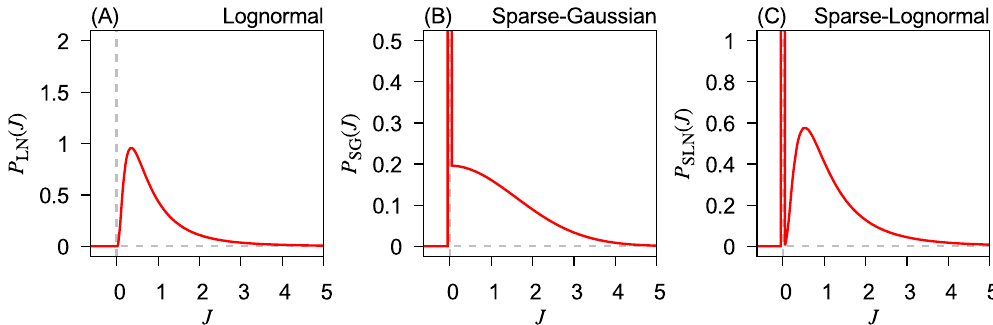
Figure 1. Probability density functions used to generate random connection strengths between neurons. ( A ) The probability density function for simple log-normal random numbers presented in Eq. (7). ( B ) The probability density function for sparse-Gaussian random numbers presented in Eq. (8). ( C ) The probability density function for sparse-log-normal random numbers presented in Eq. (9). Parameter: σ =